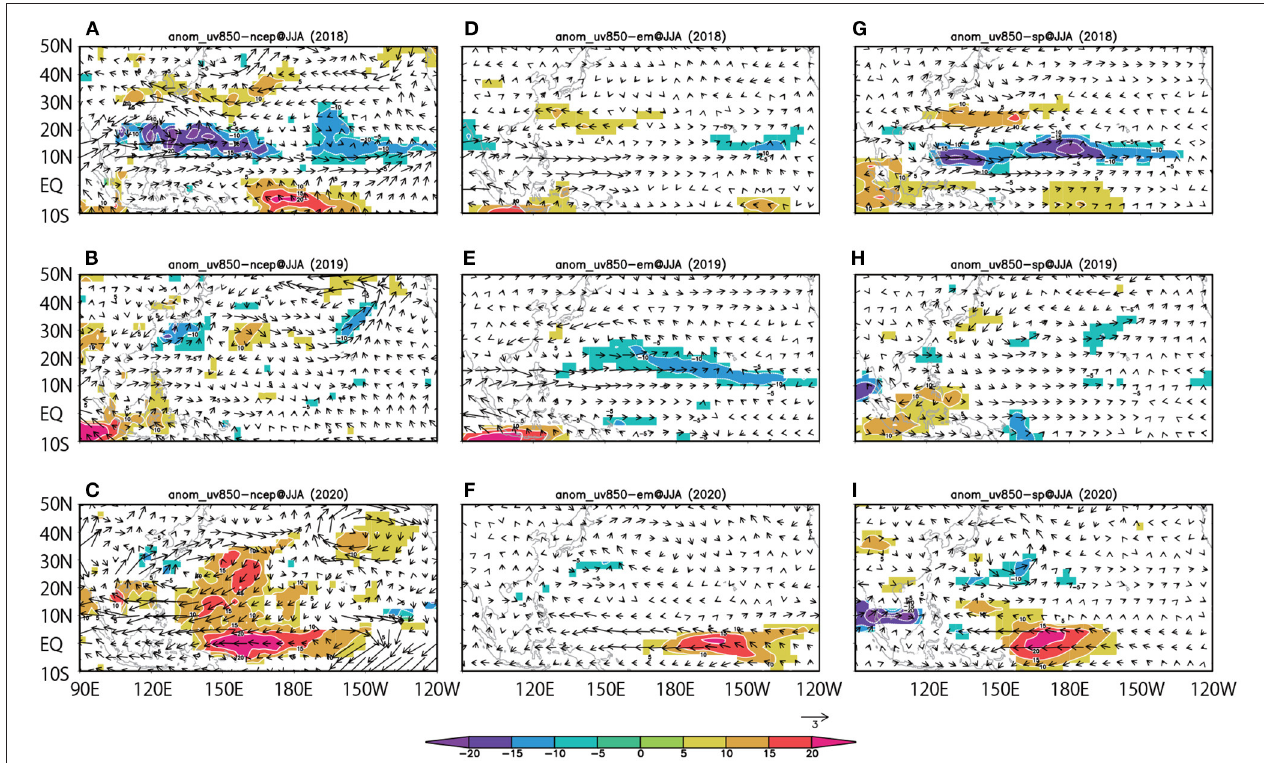
FIGURE 4 | Spatial patterns of the observed 850 hPa wind (units; m/s) and outgoing longwave radiation (OLR) (units; W/m 2 ) anomalies in JJA. (A–C) is observation (NCEP reanalysis), (D–F) is the Emanuel scheme AFES, and (G–I) is the spectral scheme AFES. OLR regions with exceeding ± 1 σ are